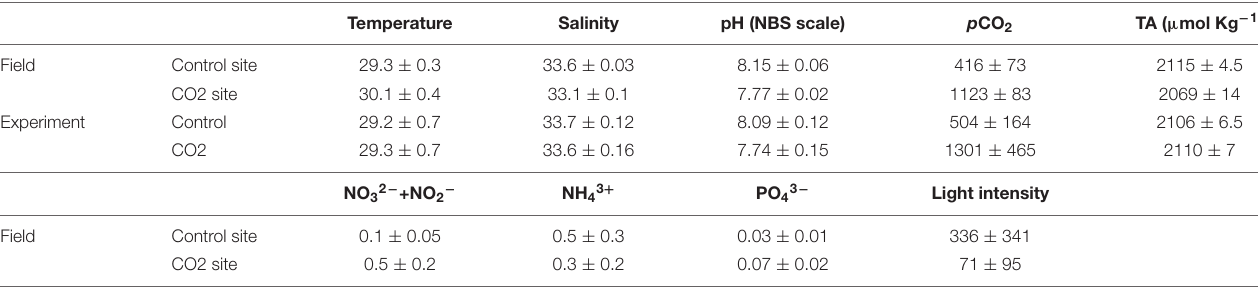
TABLE 1 | Seawater carbon chemistry and nutrient concentration measured at control and CO 2 site at field where the adult corals for the larval experiment was collected and seawater carbon chemistry during the larval experiments in